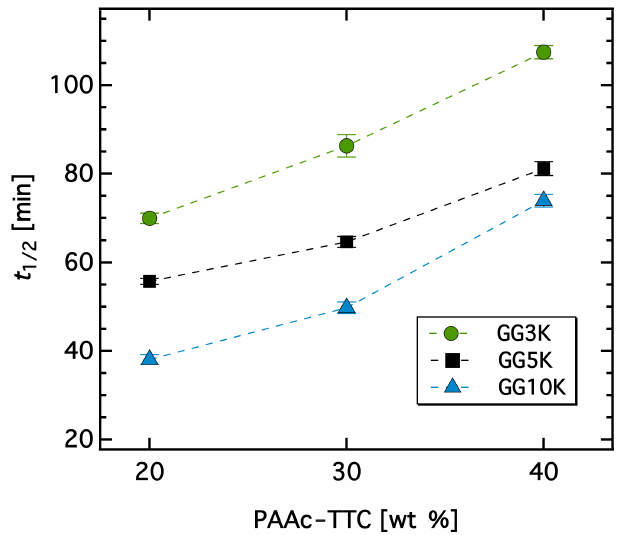
Figure 4. Plots of half-swelling time ( t 1/2 ) as a function of the PAAc content. The dynamic study was evaluated in deionised water (DI) at room temperature ( ∼ 23 ◦ C). The shape and size of the cylindric hydrogel samples were constant ( 5 mm in diameter and 2 mm in